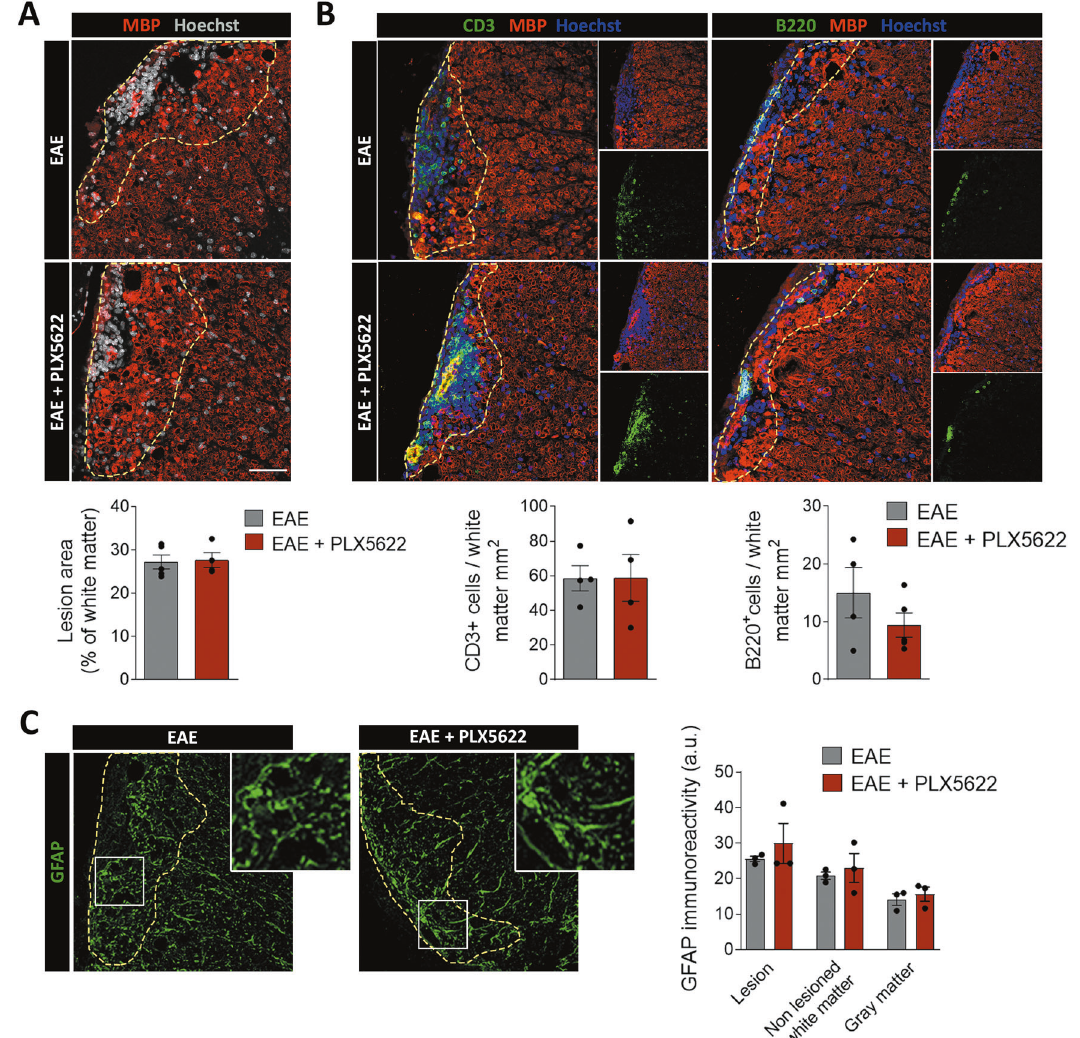
Fig. 2 PLX5622 microglial depletion does not alter EAE chronic phase. A Representative images of EAE lesions in the lumbar spinal cord of control and PLX5622-treated mice (dpi 30 – 35). The histogram shows the percentage of lesioned white matter versus total white matter ( n = 5). Scale bar = 50 µm. B Representative images showing the accumulation of CD3 + T cells and B220 + B cells in EAE lesions in control and PLX5622-treated at EAE chronic phase (dpi 30 – 35). Scale bar = 25 µm. Histograms show the number of T cells and B cells normalized to total white matter ( n = 4). C Representative images of GFAP astrocyte immunoreactivity, indicative of astrogliosis, in lesioned and non-lesioned white matter of control and PLX5622-treated mice at EAE chronic phase (dpi 30 – 35; n = 3). Dashed lines delineate white matter lesions in all images. Insets show higher magni fi cation of the indicated boxes. Data are presented as means ±